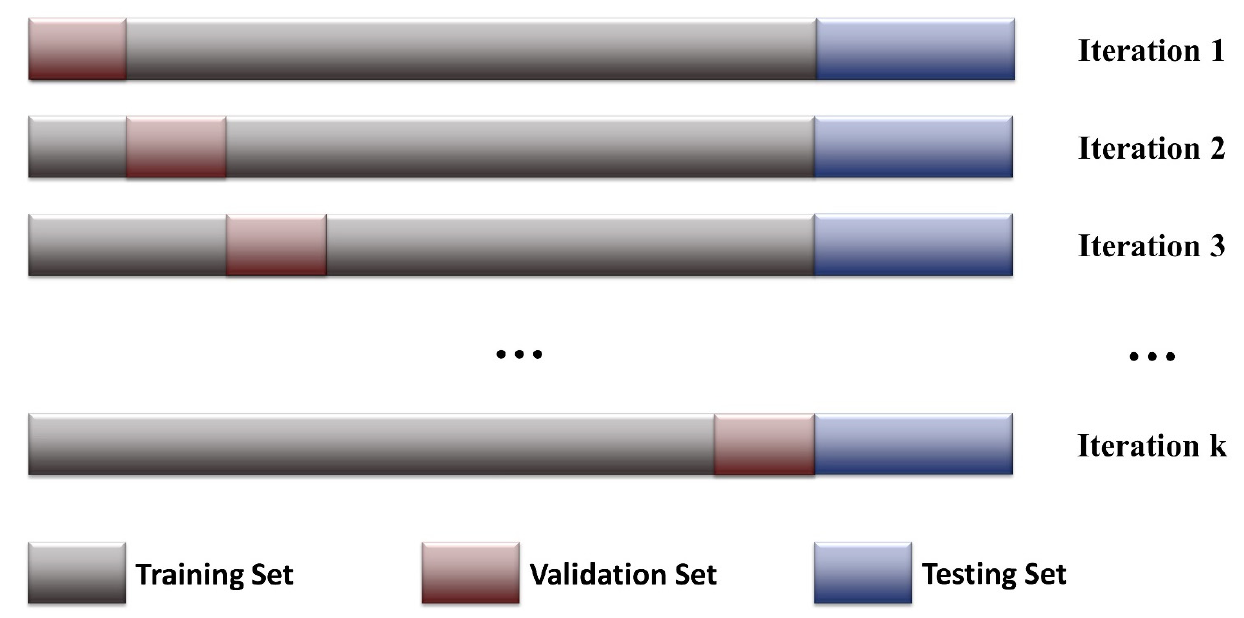
Figure 2. Schematic diagram of the blocked cross-validation.